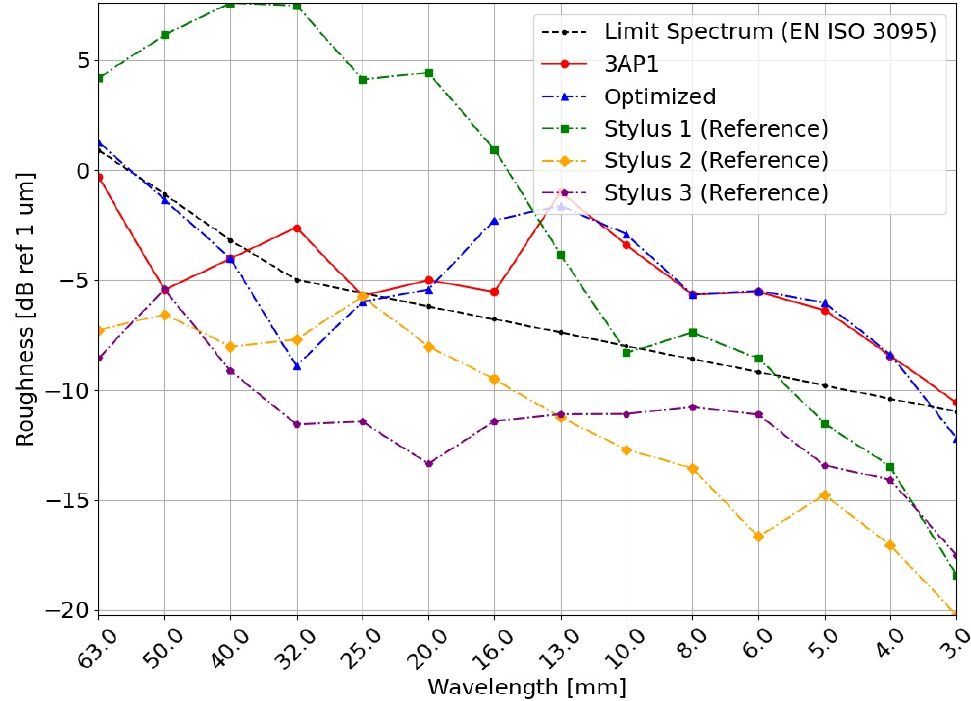
Figure 8. Spectrum of acoustic roughness for measurement of the optical system near reference section B, compared with reference section B and the limit spectrum from EN ISO 3095 [22].